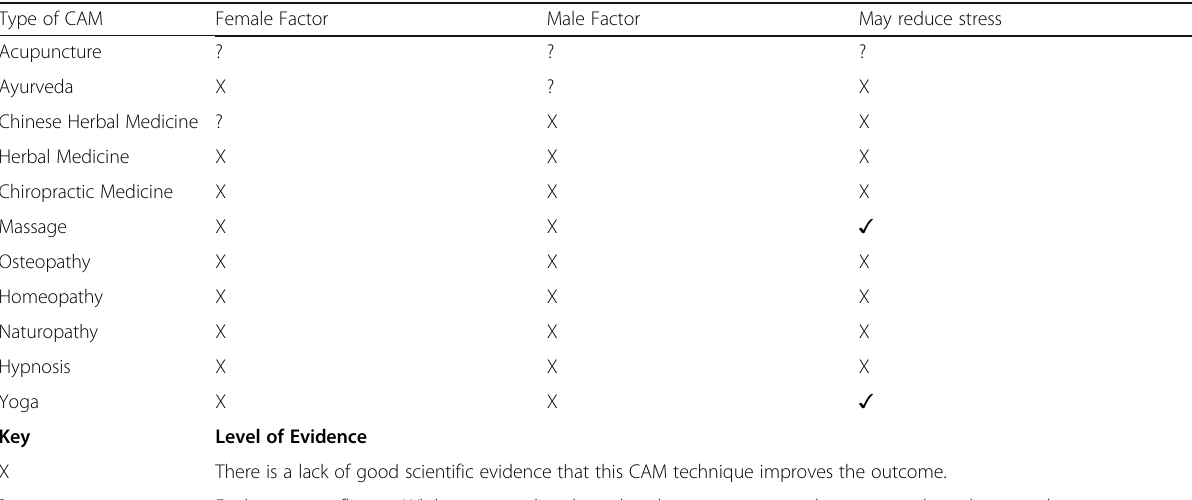
Table 6 Overall Summary of CAM Outcomes Type of